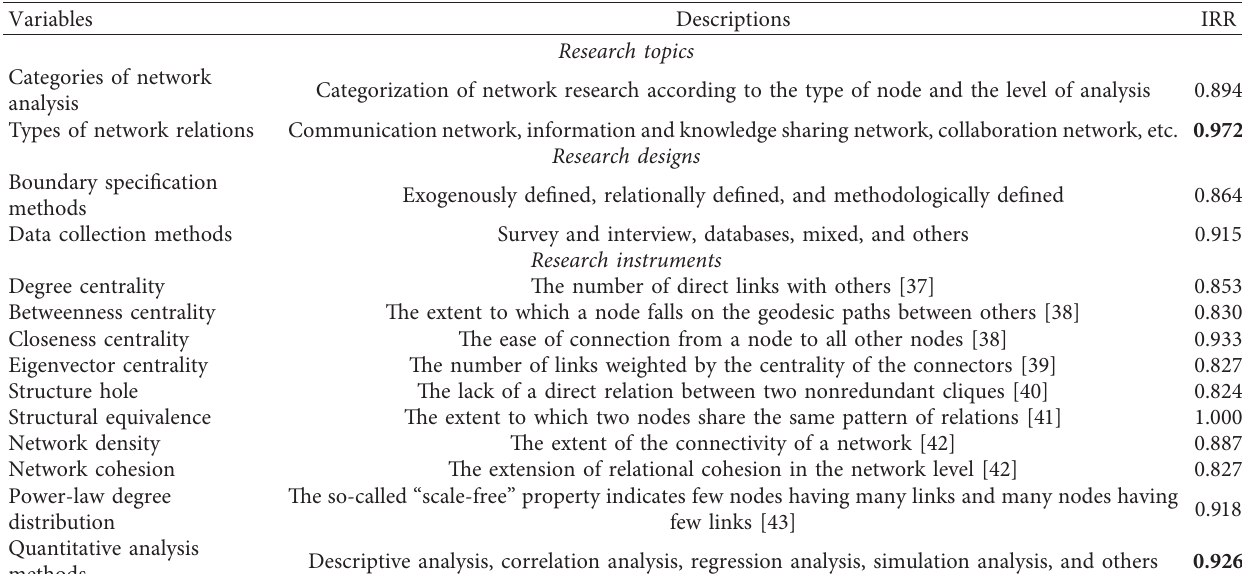
Table 2: Description and interrater reliability of collected variables.